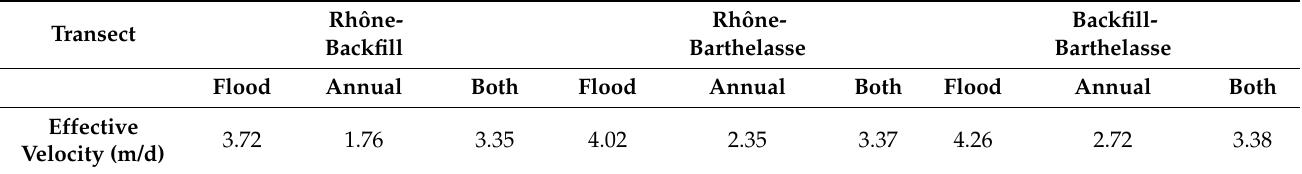
Rh ô ne- Barthelasse